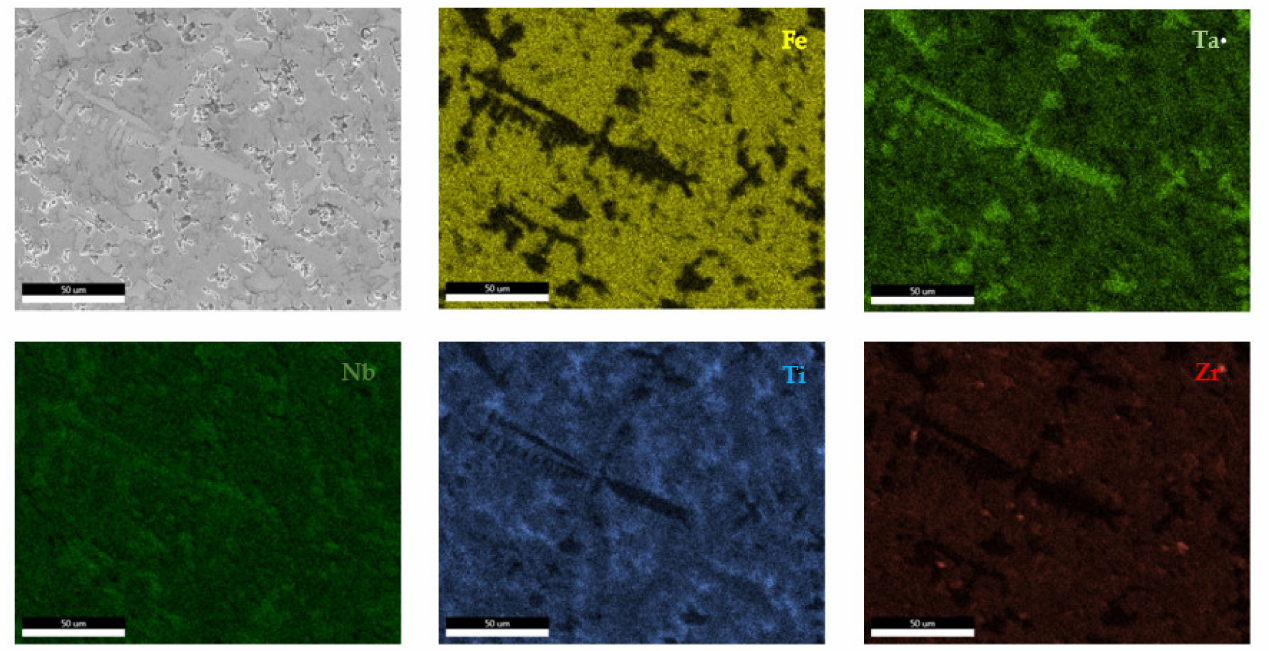
Figure 16. EDS mapping of FeTa 0.5 Nb 0.5 TiZr 0.5